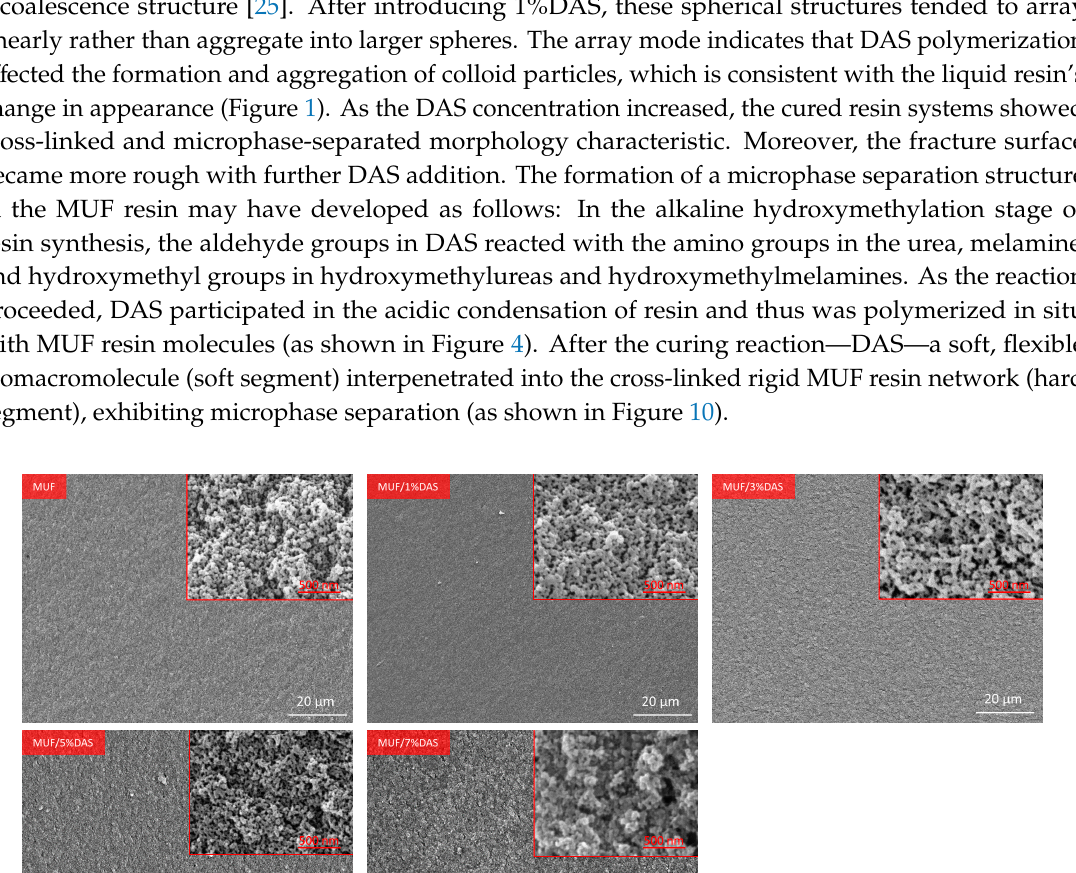
Figure 10. In situ polymerization and microphase separation structure in DAS-modified MUF resin. 3.6. Toughening and Enhancing of DAS-Modified MUF Resin The mechanical properties of filter paper impregnated with neat and DAS-modified MUF resins were evaluated with tensile and impact testing. The tensile strength (Ts) and elongation at break (E) are listed in Table 4. The cured MUF resin is a brittle cross-linking network; thus, the filter paper impregnated with the neat MUF resin obtained a Ts value of 17.21 MPa and a low E value of 1.33%. However, the Ts and E values of the impregnated paper gradually increased as the DAS concentration increased, indicating that the MUF resin was significantly enhanced and toughened. The impregnated paper using modified MUF resin with 3% DAS obtained a Ts of 30.11 MPa and an E value of 2.97%, reflecting an increase of 74.96% and 48.12%, respectively, over the values obtained by the neat MUF resin. These increases in mechanical properties resulted from the in situ polymerization and microphase separation structure of DAS. The former effectively improved the cross-linking density of the cured hybrid system (Figure 6); the latter made the cured system more conducive to transfer and stress dispersal when loading external force [11].